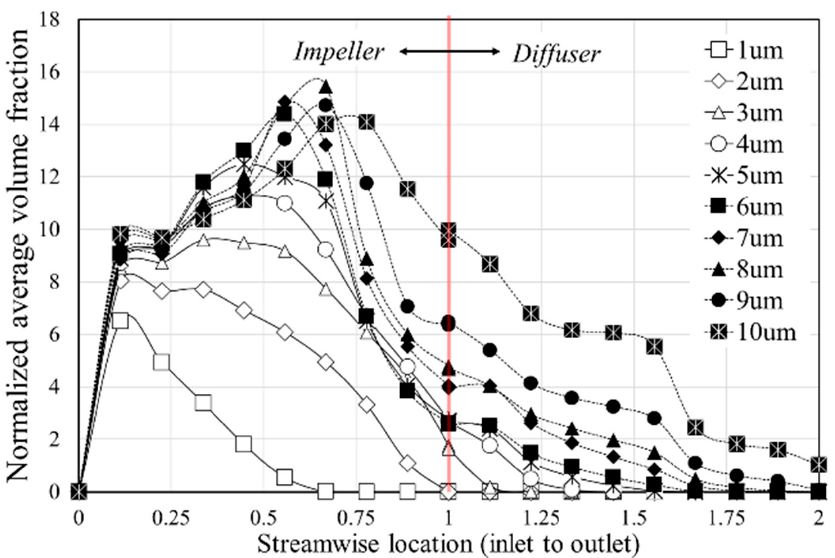
Figure 19. Averaged volume fraction along the streamline position with different droplet sizes.